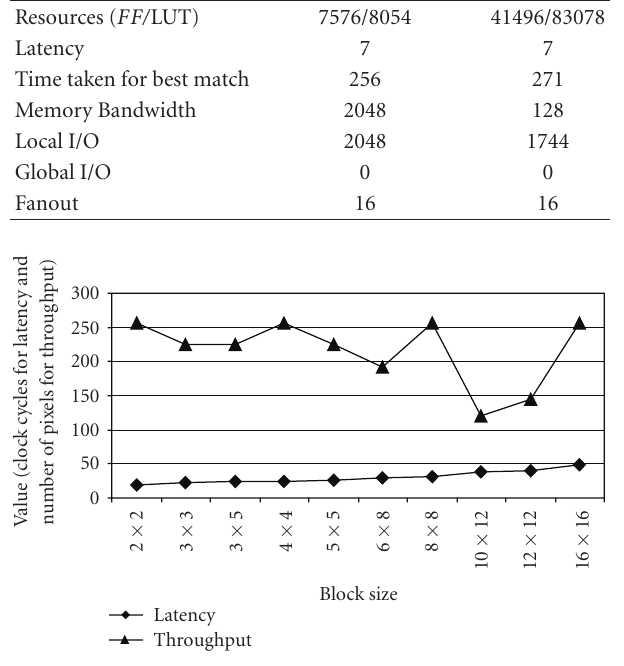
Figure 14: Latency and throughput of proposed architecture for various block